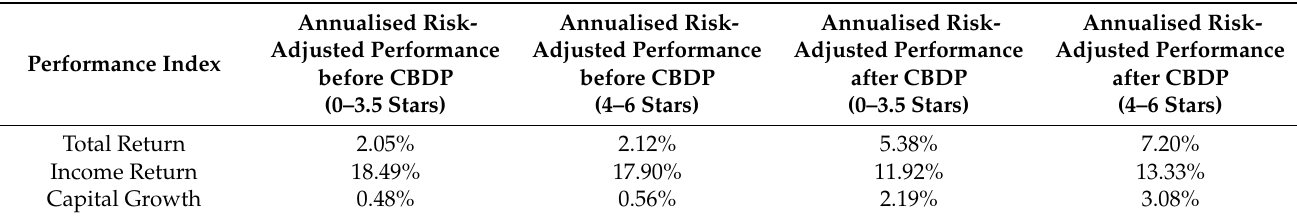
Table 5. Prime market—risk-adjusted performance non-green (0–3.5 stars) vs. green (4–6 stars).